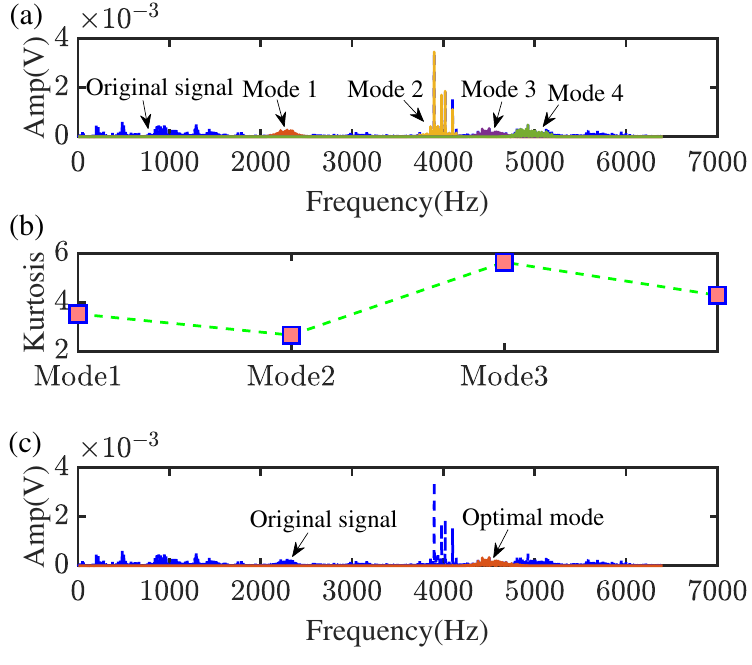
Figure 16. Extraction result by the proposed method: ( a ) extracted modes; ( b ) the kurtosis of different modes; ( c ) the optimal target mode.